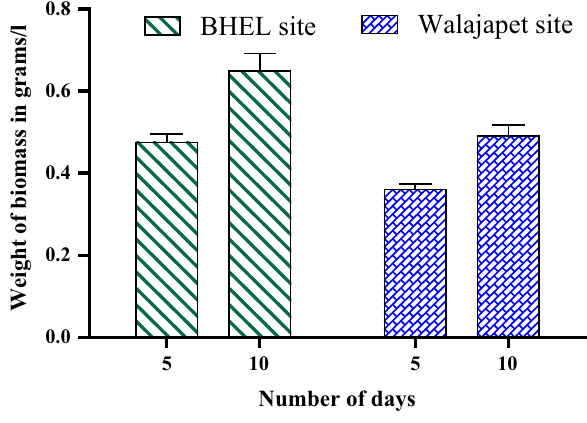
Fig. 7 Biomass of the potent strain during large-scale effluent treat-